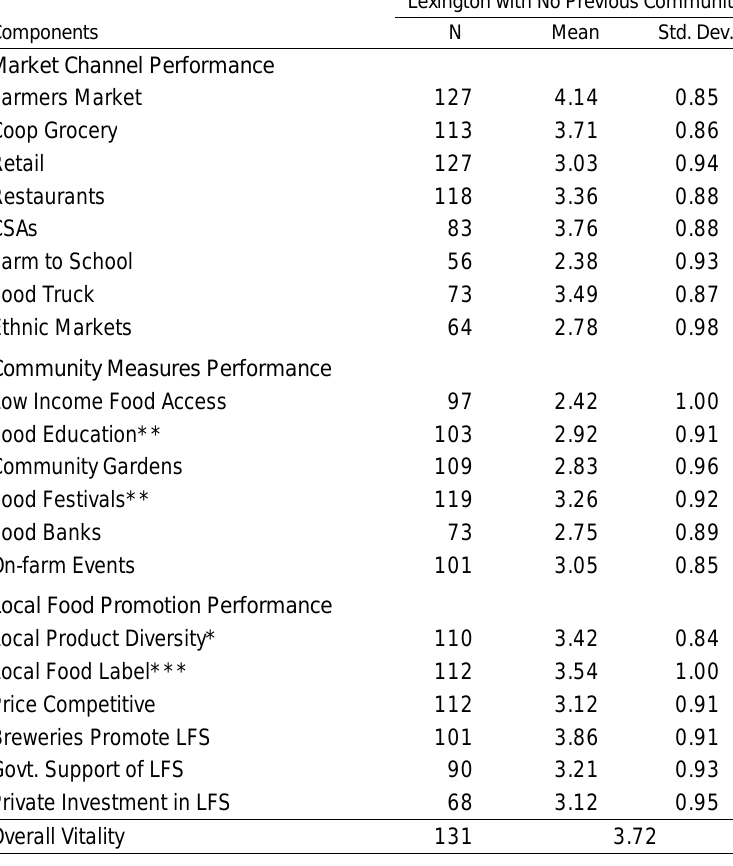
Table 2. Long-time Resident Perceptions of Lexington’s LFS Lexington with No Previous